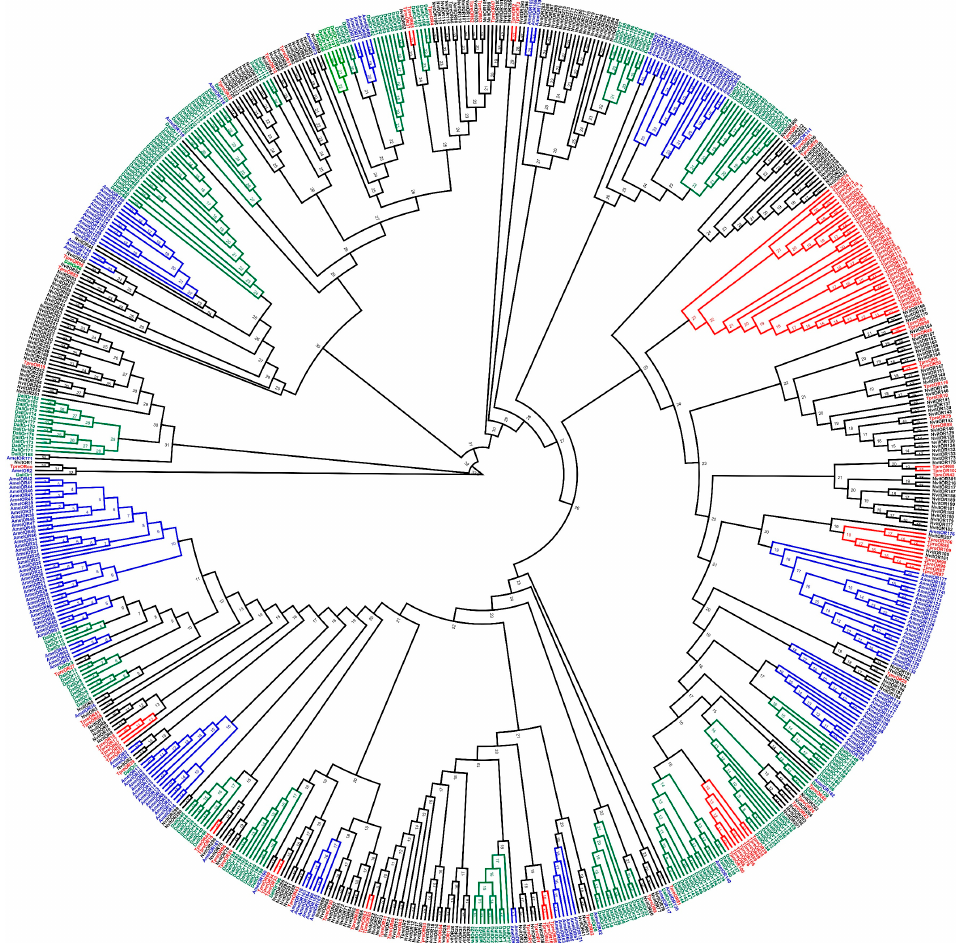
Figure 4. Phylogenetic analysis of ORs from T. pretiosum (TpreORs), A. mellifera (AmelORs), N. vitripennis (NvitORs) and D. alloeum (DallORs). 105 TpreORs are marked in red, 163 AmelORs are marked in blue, 301 NvitORs are marked in black, and 187 DallORs are marked in green. The ORCO (*) subfamily formed by TpreORCO, NvitOR1, DallOR1 and AmelOR2 are highlighted.